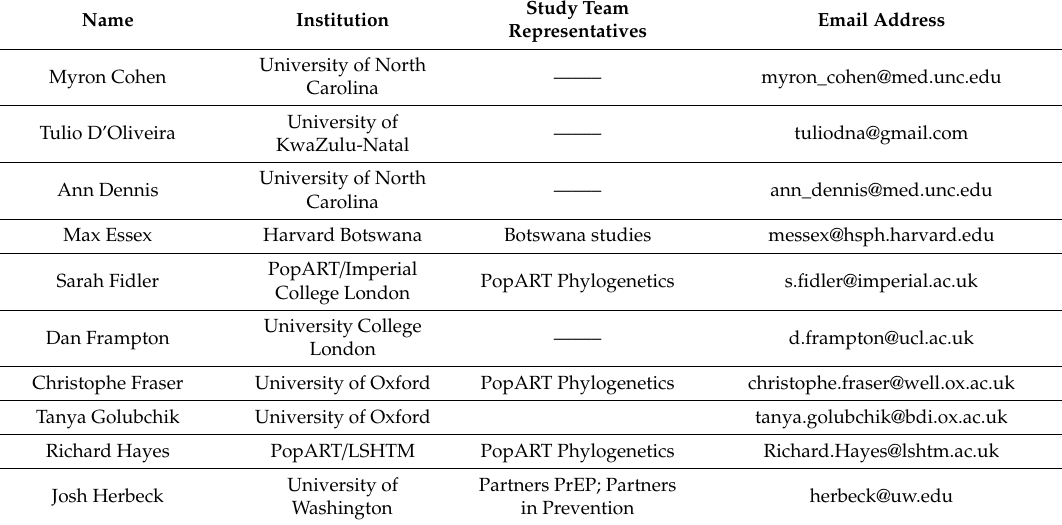
Table A2. PANGEA 1 Steering